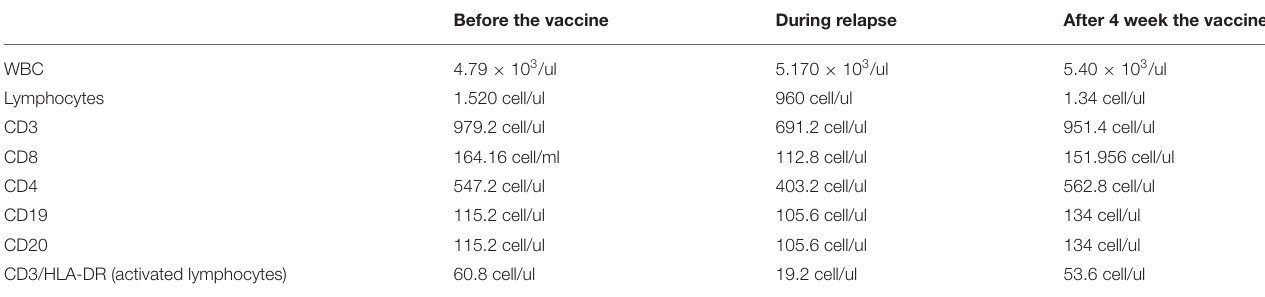
TABLE 1 | Lymphocytes subsets before and after the vaccination and during the relapse.